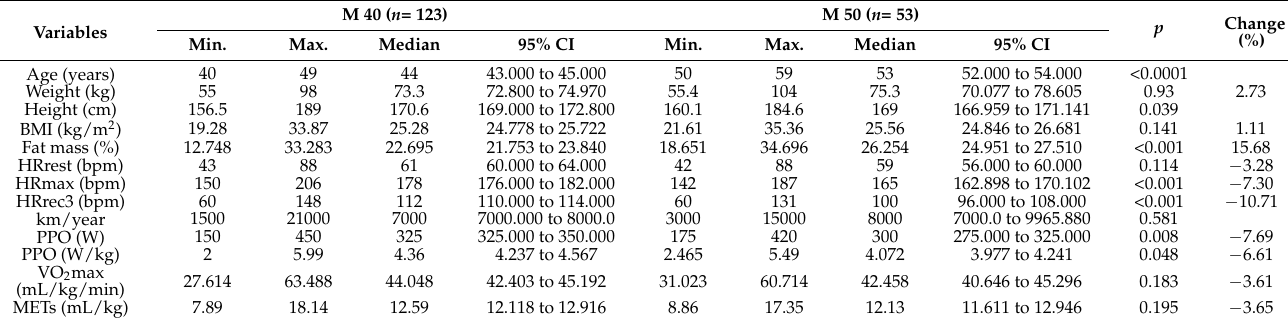
Table 1. Body composition and cardiovascular fitness variables of the